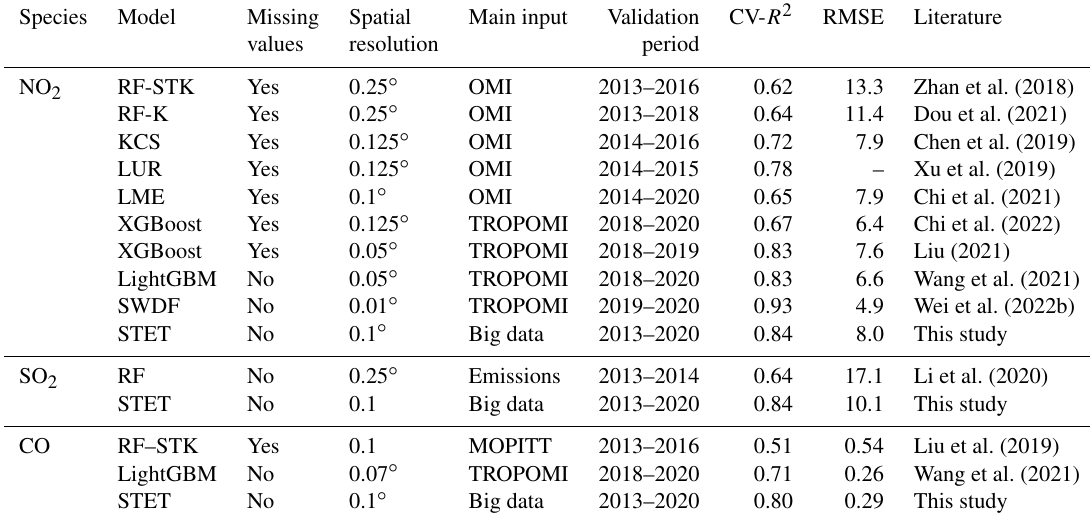
Table 2. Comparison of long-term datasets of different gaseous pollutants in China. Species Model Missing